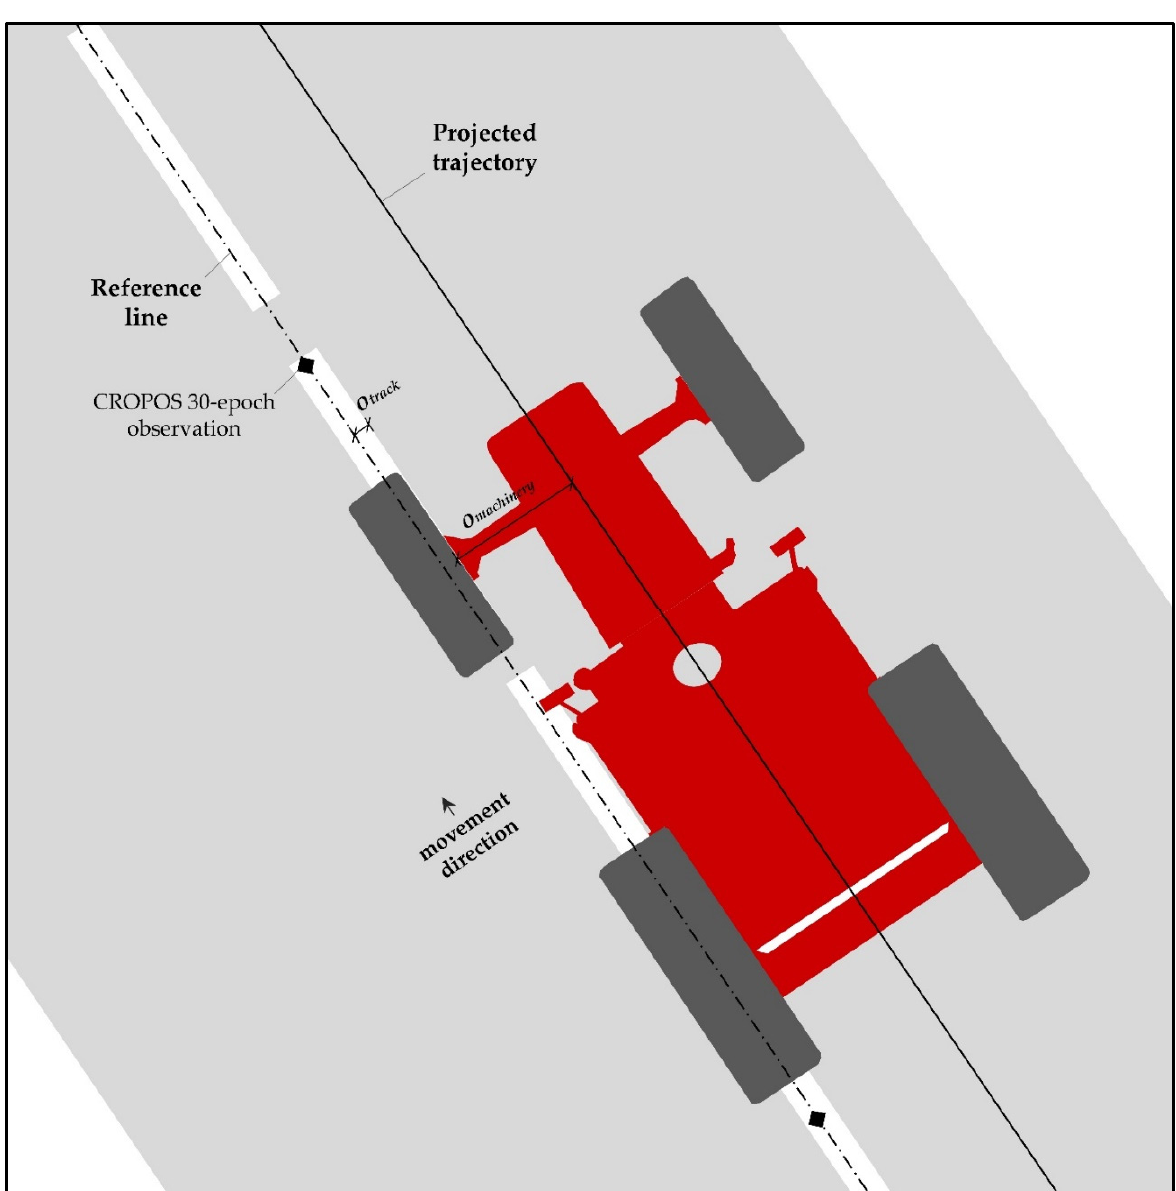
Figure 3. Definition of the projected trajectory according to the reference line.